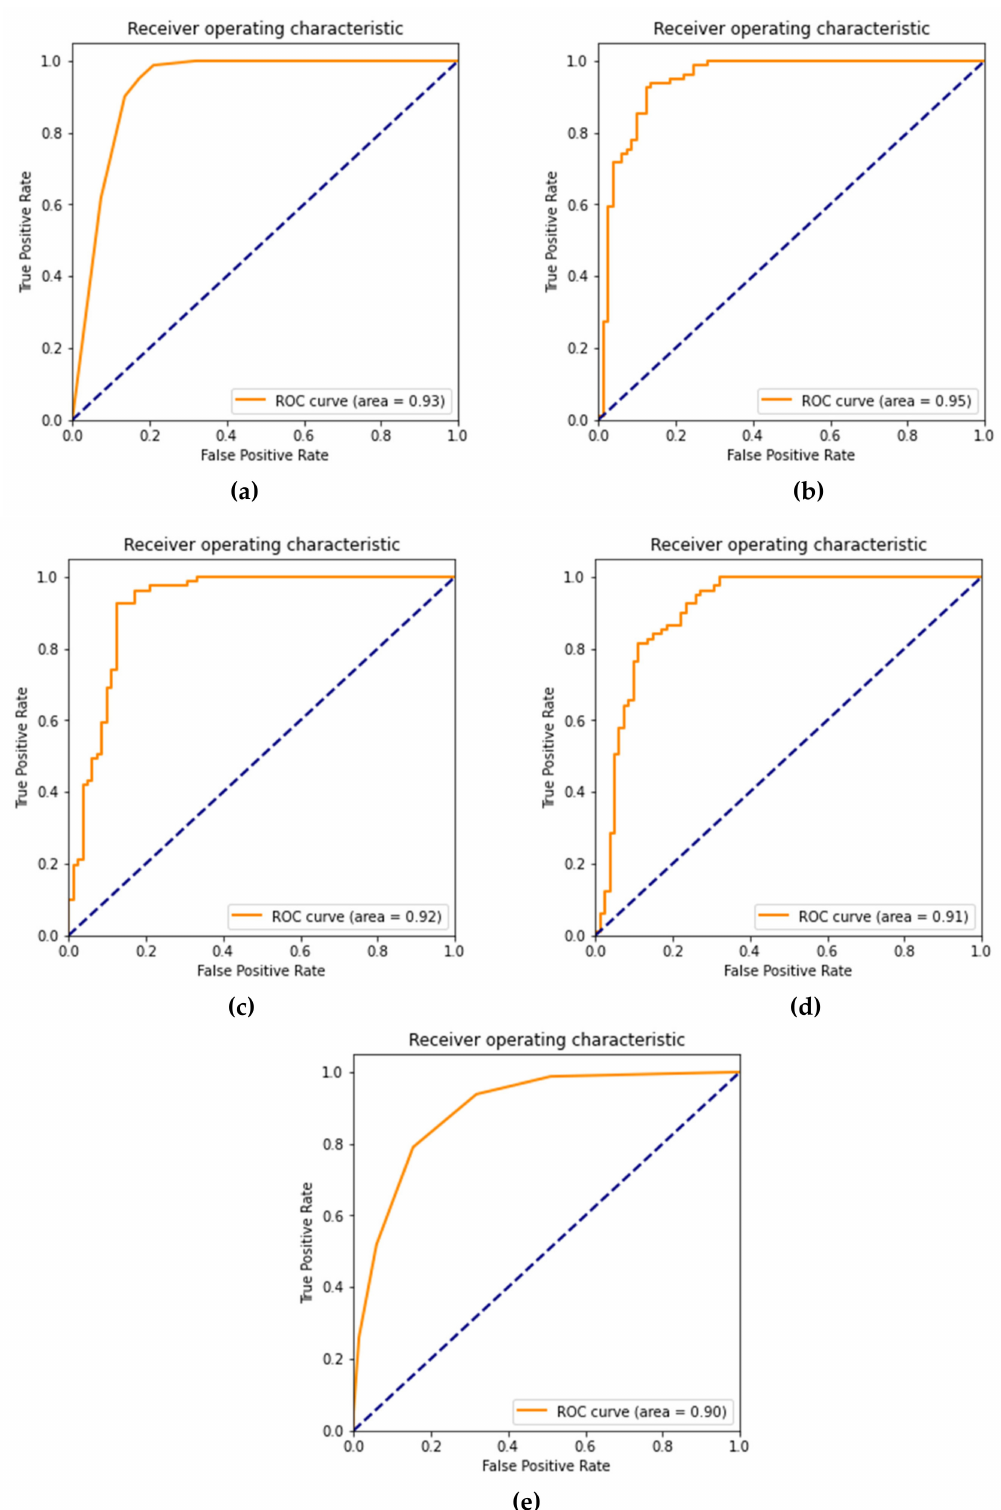
Figure 8. Evaluation of the landslide susceptibility maps (balanced by GAN) based on the AUROC test using: ( a ) ANN, ( b ) RF, ( c ) DT, ( d ) KNN, and ( e )